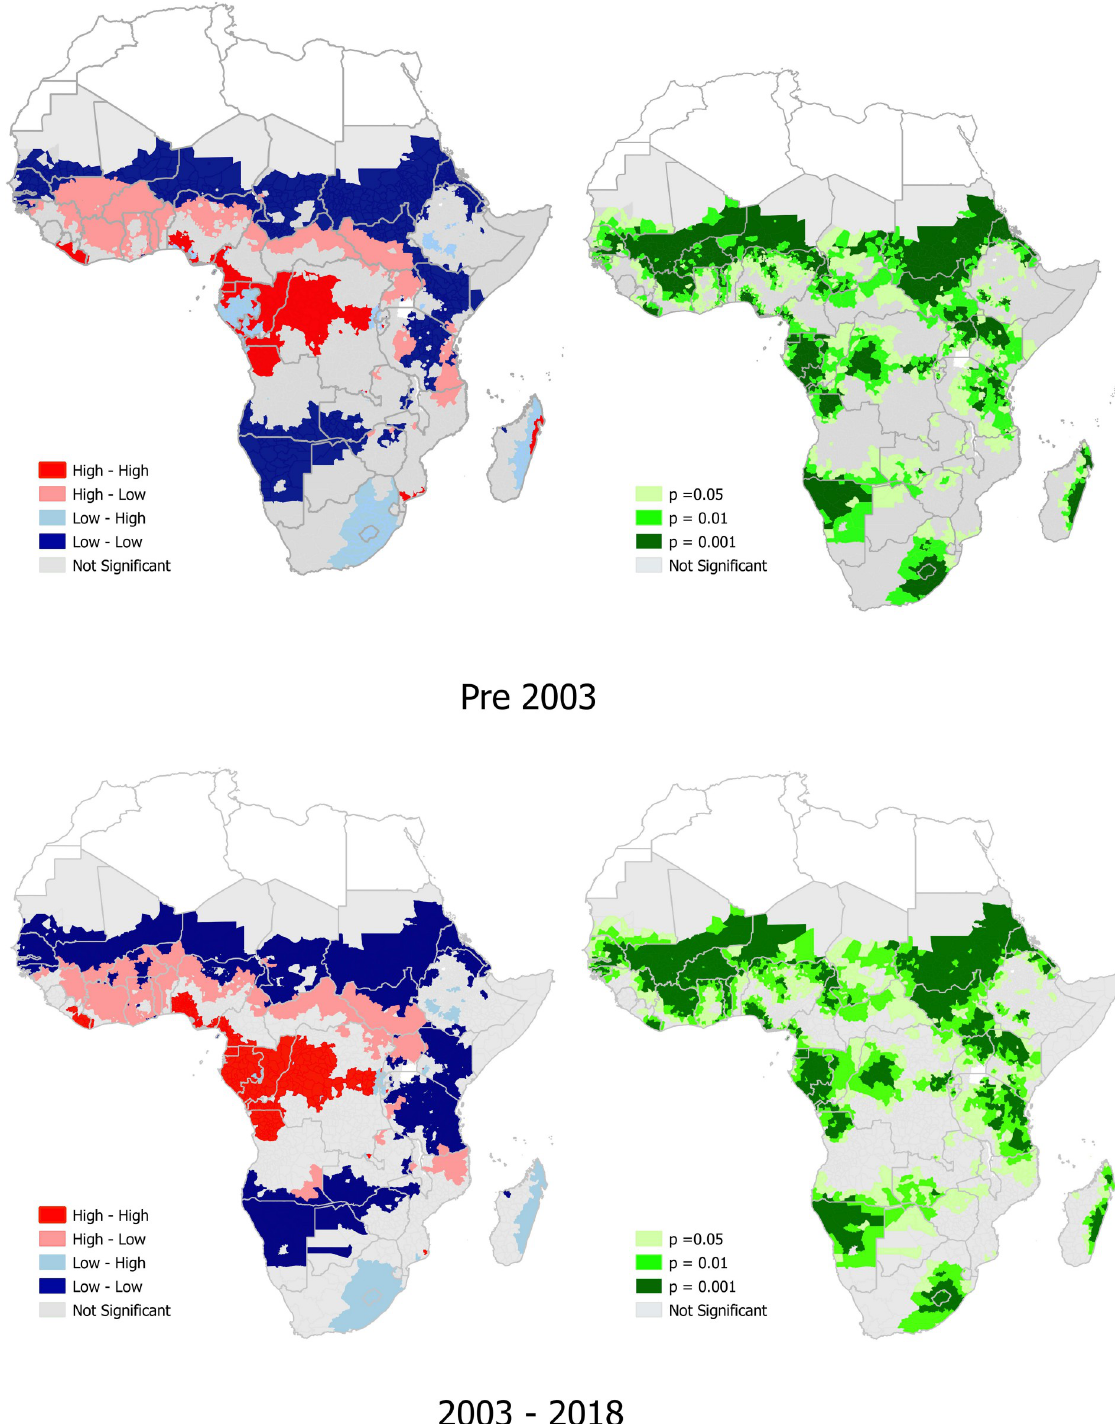
Fig 3. The prevalence of P . falciparum and Ascaris lumbricoides , and significant hotspots of P . falciparum and A . lumbricoides co- endemicity in sub-Saharan Africa. The density description next to the colour-coded box refers, to the prevalence of P . falciparum whilst the column further to the right refers to density of A . lumbricoides . Link to the base layer of the map: https://gadm.org/index.html.